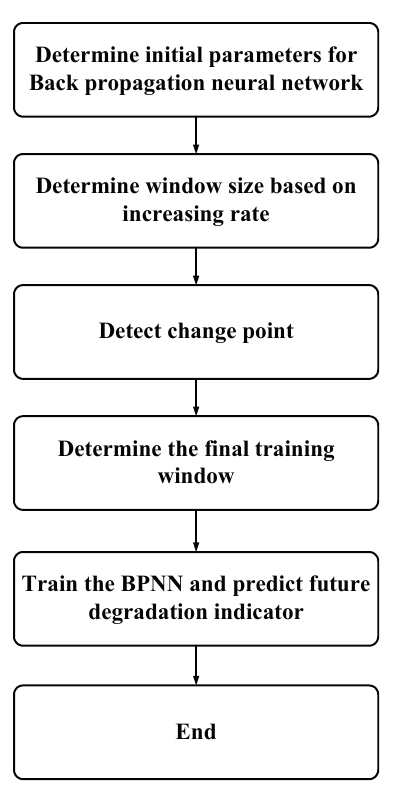
Figure 10. Whole process of RUL prediction based on the proposed